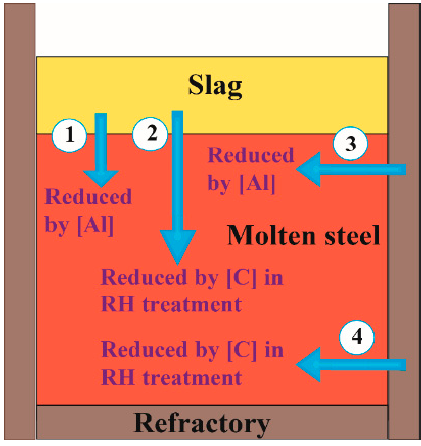
Figure 5. Evolution of mean mass fraction of inclusions.